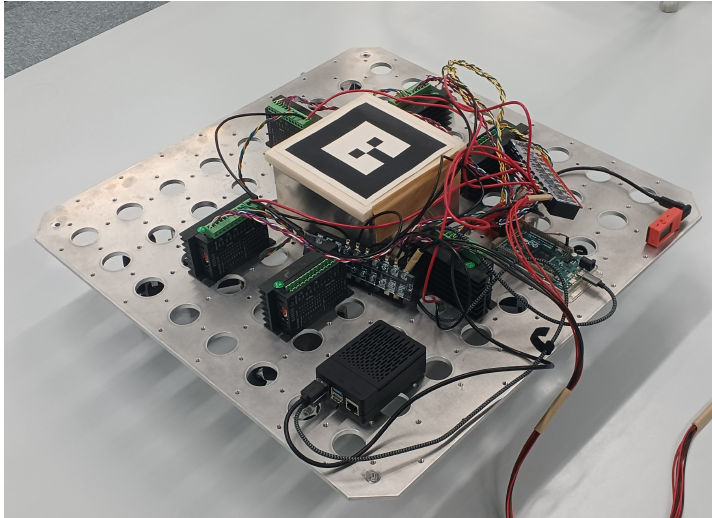
Figure 4. Appearance of the robot.